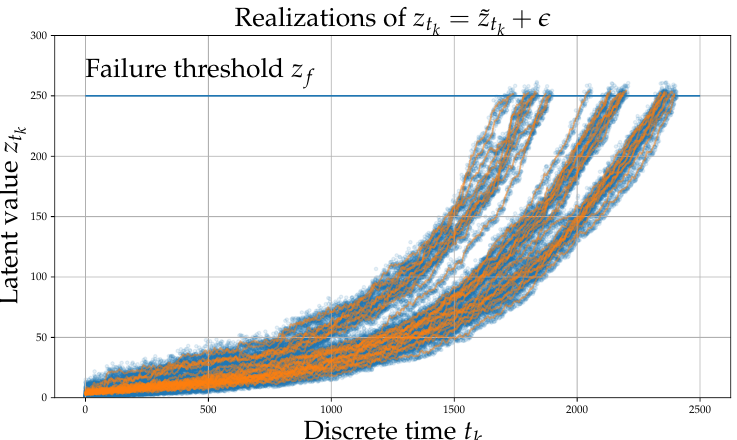
Figure 1. Simulated latent variable z t